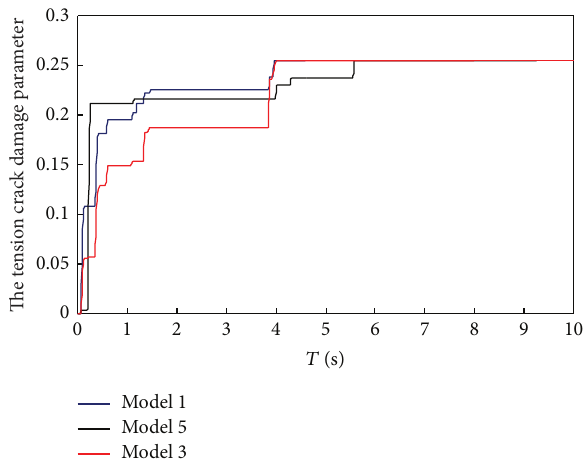
Figure 39: The parameter ratio of pier between windows and spandrel under Lixian County ground motion.